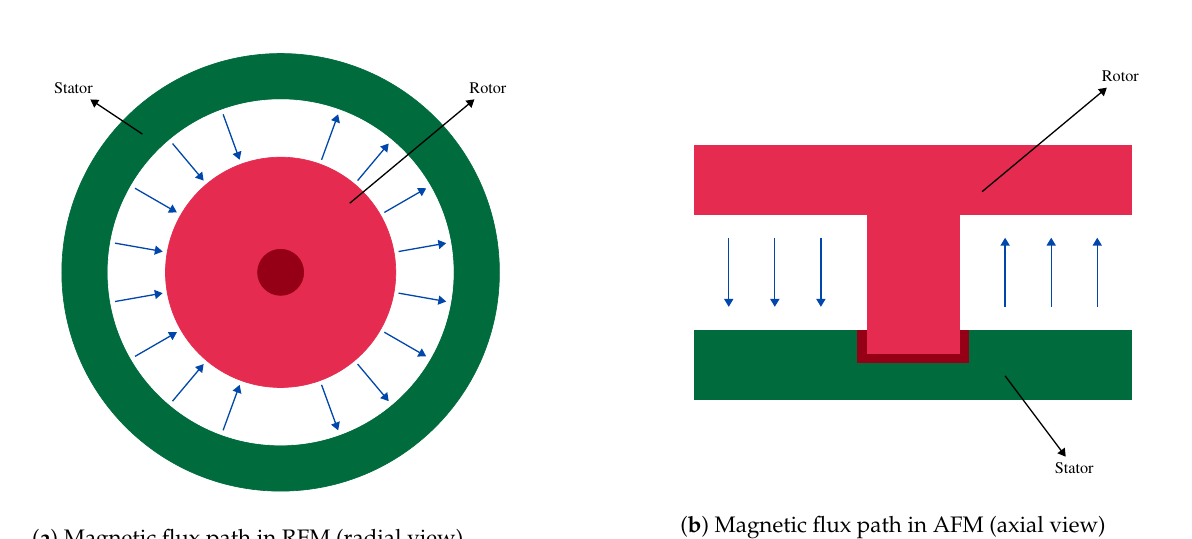
Figure 3. Magnetic flux is produced ( a ) radially along the rotor in RFM ( b ) axially along the axis of rotor in AFM.